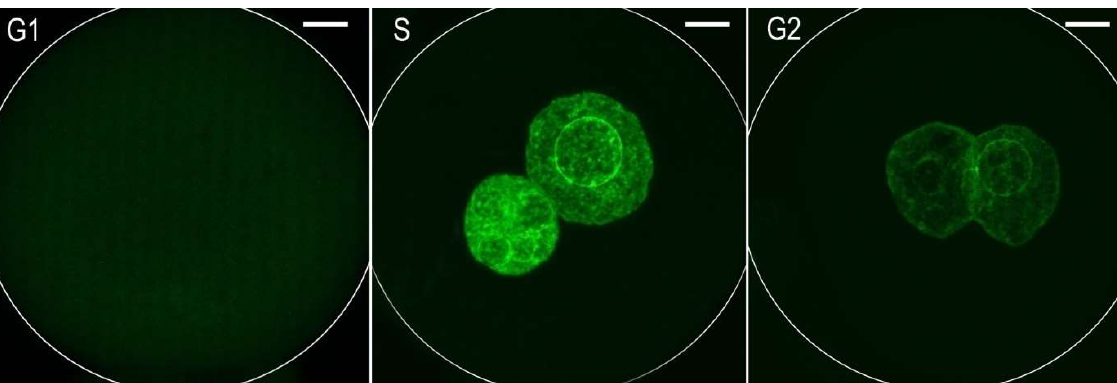
Figure 1. Immunofluorescence labeling the of5-ethynyl-2´-deoxyuridine (EdU) incorporated into DNA separately during the G1-phase, S-phase, or G2-phase in one-cell mouse embryos. The Z-projection of the confocal sections across the whole pronuclei is shown. Scale bar = 10 µm.